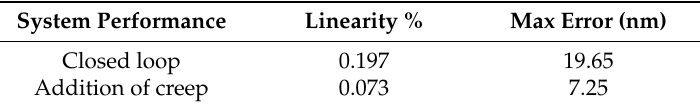
Table 4. Precision stage